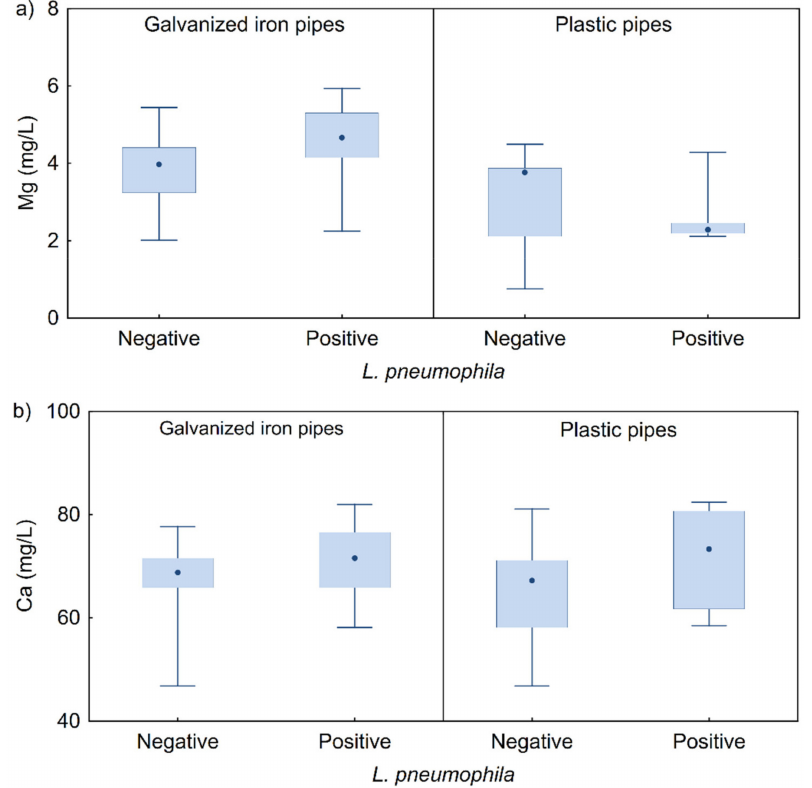
Figure 6. Negative and positive L. pneumophila samples as a function of concentration of ( a ) Mg and ( b ) Ca ion (interquartile range—IQR), in water from the galvanized and plastic piping